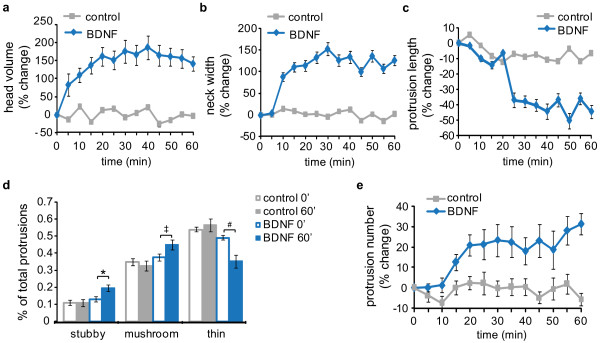
Acute BDNF treatment induces maturation of the dendritic spine population. 11 DIV hippocampal neurons were transfected with a vector expressing Lifeact-ruby, and 24 hrs later, the neurons were treated with vehicle or 100 ng/ml BDNF followed by time-lapse imaging every 5 minutes for 1 hr. Each protrusion was tracked across time and measured using the automated method. (a) Head volume was plotted as the percent change from the initial time point (T0). Statistical analyses were performed to compare protrusion head volume at T0 and T60 (N = 105 - 135 spines; Kruskal Wallis test with repeated measures; Control: P = 0.548; BDNF: P = 0.001). (b) Neck width was plotted and analyzed as above (Control: P =0.91; BDNF: P = 0.0002). (c) Dendritic protrusion length was plotted and analyzed as above (Control: P = 0.648; BDNF: P = 0.017). (d) Dendritic protrusions were classified as stubby, mushroom, or thin at each time point. The percentages of total protrusions within each class are presented for T0 and T60 (*P = 0.038, ‡P = 0.044, #P = 0.015). (e) The number of protrusions within a dendritic region was determined using Imaris Filament Tracer and compared between T0 and T60 (N = 25 - 30 neurons; repeated measures ANOVA, post-hoc Tukey's test [Control: P = 0.219; BDNF: P = 0.014]).